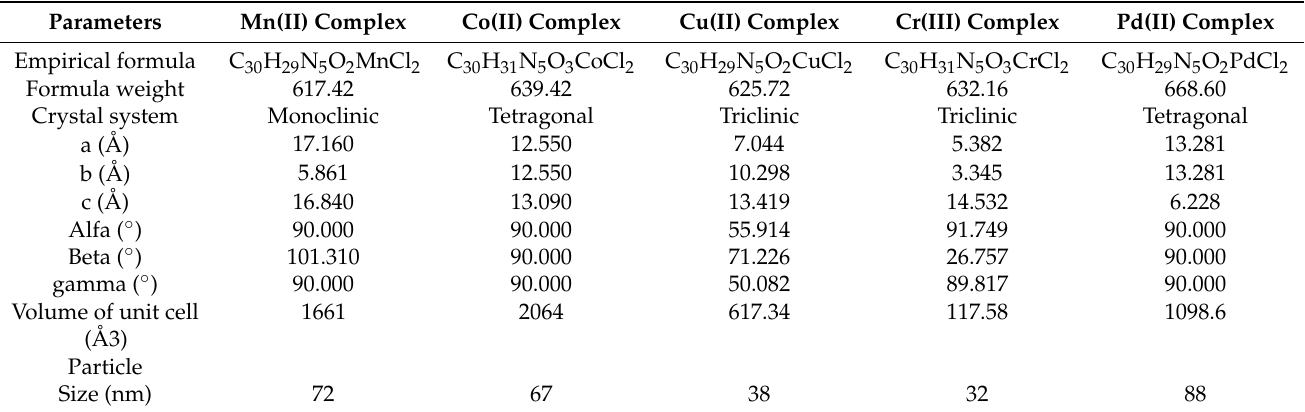
Table 4. X-ray powder diffraction crystal data of complexes.